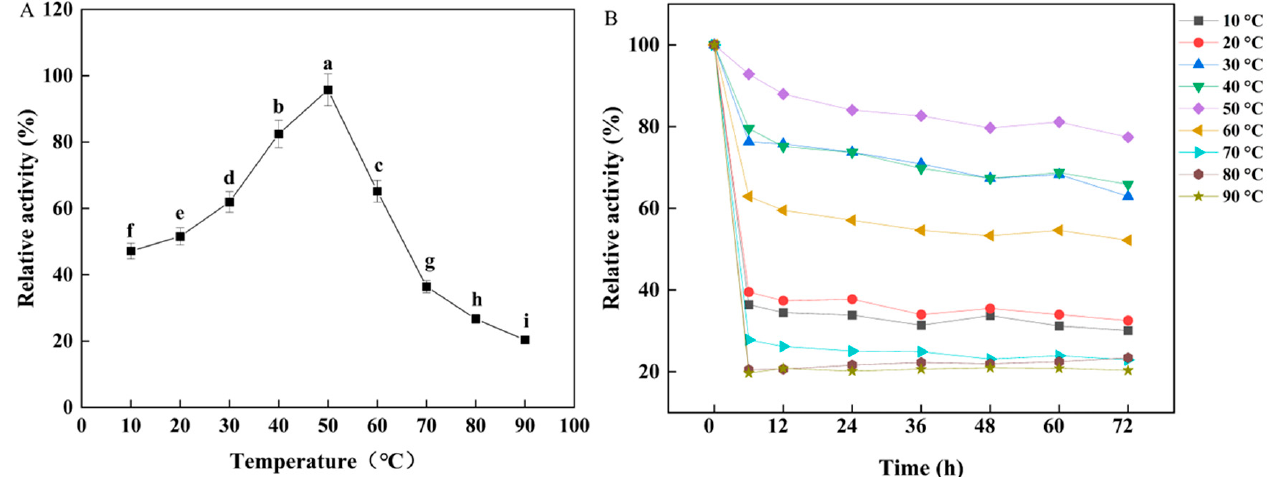
Figure 4. Effects of temperature ( A ) and temperature stability ( B ) on the enzyme activity of W. cibaria F1. Different letters in superscript donate significant difference ( p < 0.05).